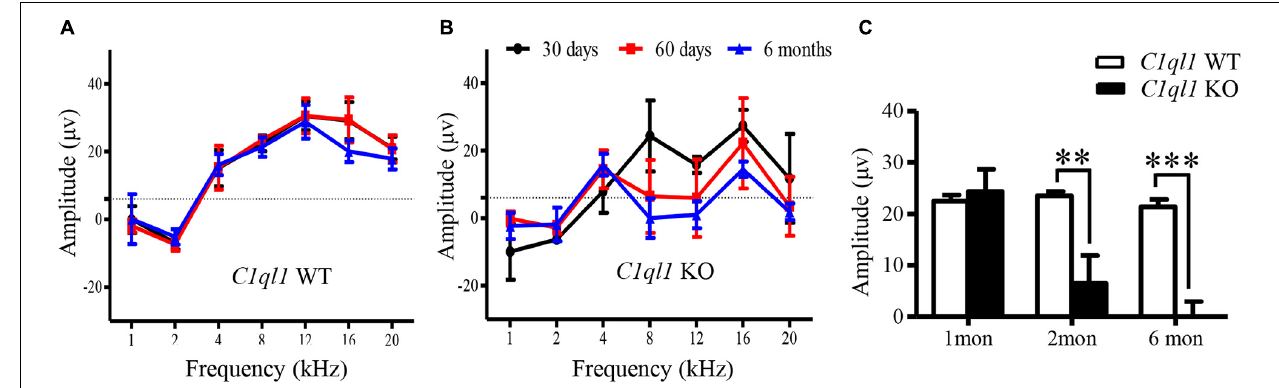
FIGURE 3 | Changes of DPOAE in C1ql1 KO mice. (A,B) DPOAE in C1ql1 WT mice and C1ql1 KO mice. (C) Statistical differences in DPOAE between C1ql1 KO mice and C1ql1 WT mice in postnatal 1, 2, and 6 months at 12 kHz ( n = 4). Statistical significance was defined as ∗ P < 0.05, ∗∗ P < 0.01, and ∗∗∗ P <